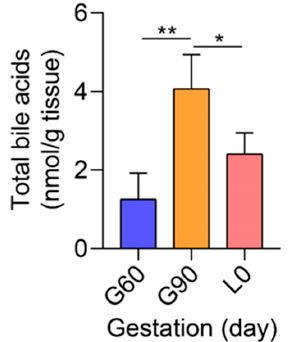
Figure 6. The total bile acids (TBA) of placentas used for RNA-Seq at G60, G90, and L0. n = 3–4 / group. Data are shown as means ± SE, * p < 0.05, ** p < 0.01.